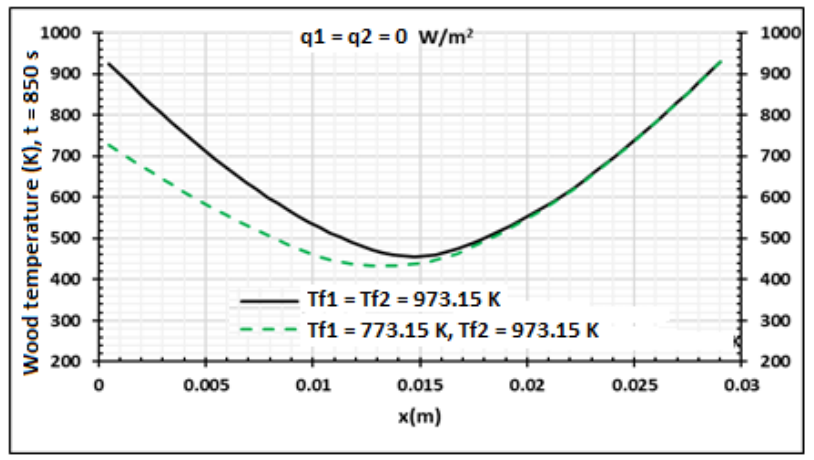
Figure 12. Wood temperature distribution at q 1 = q 2 = 0 W/m 2 using samples of 30 mm thickness, ρ bo = 700 kg/m 3 . Influence of the contact temperature, t = 850 s.